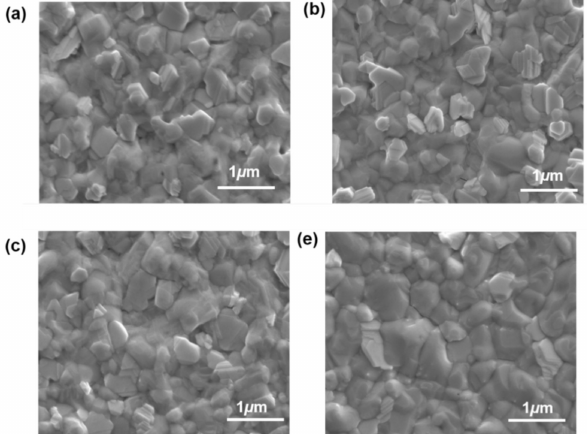
Figure 4. SEM images of perovskite films deposited on the different ETLs: ( a ) TiO 2 ( b ) 0.1 ( c ) 0.2 and ( d ) 0.3 proportion of SnO 2